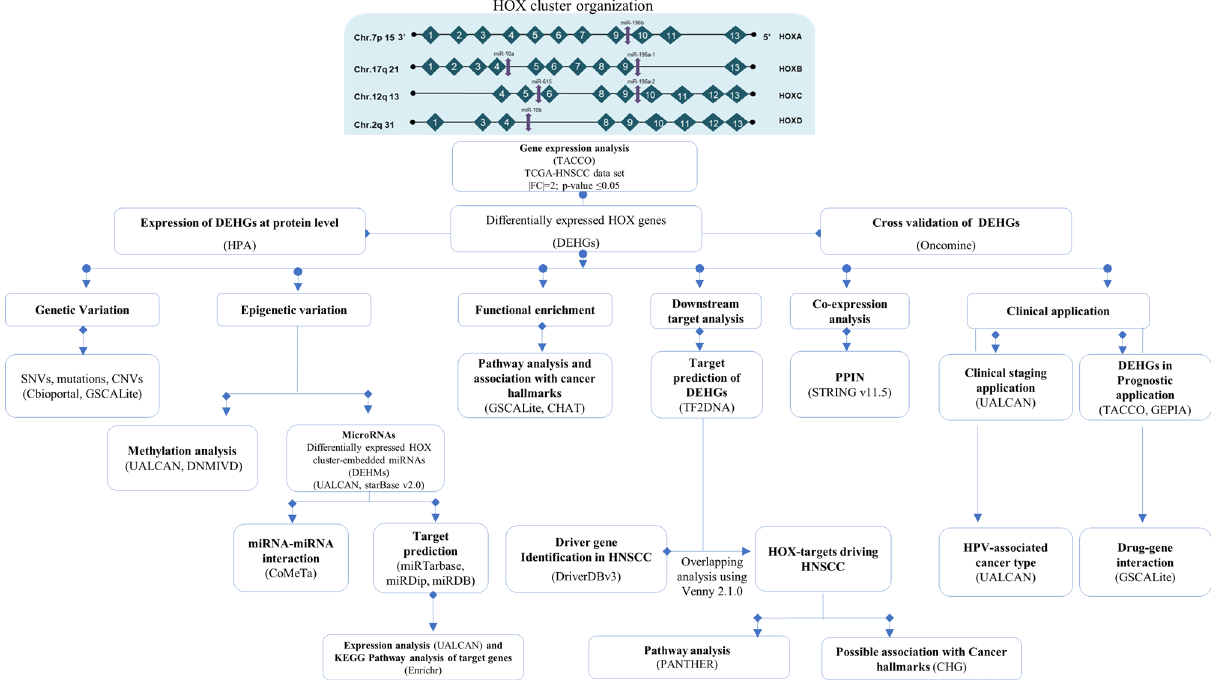
Figure 1. The workflow of in silico analysis of the HOX genes and HOX-embedded miRNA network in Head and Neck Squamous Cell Carcinoma (HNSCC).